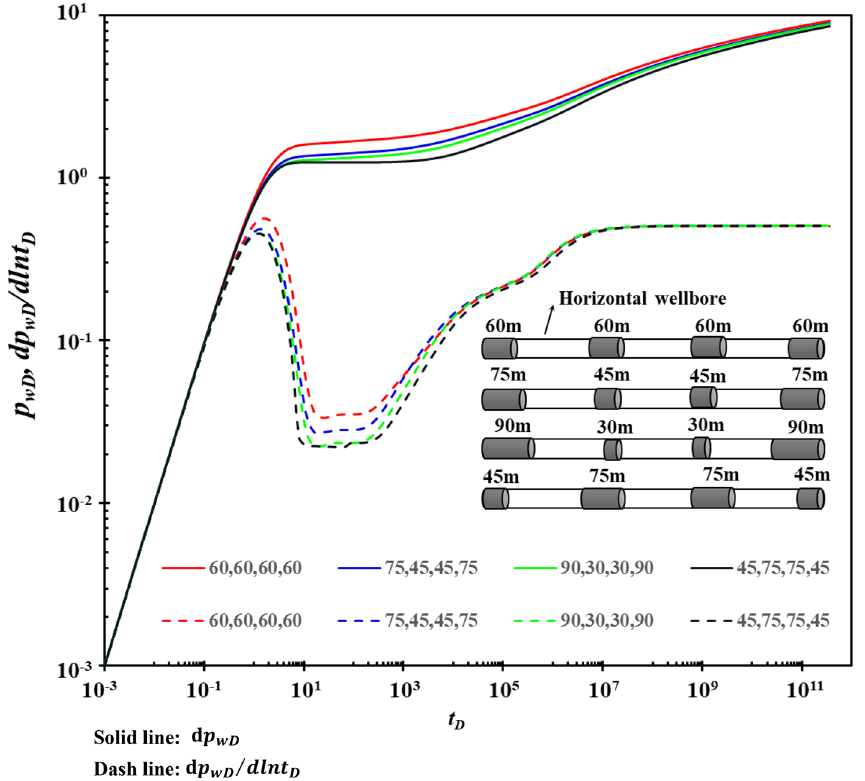
Figure 11. The effect of section length and distribution mode on type